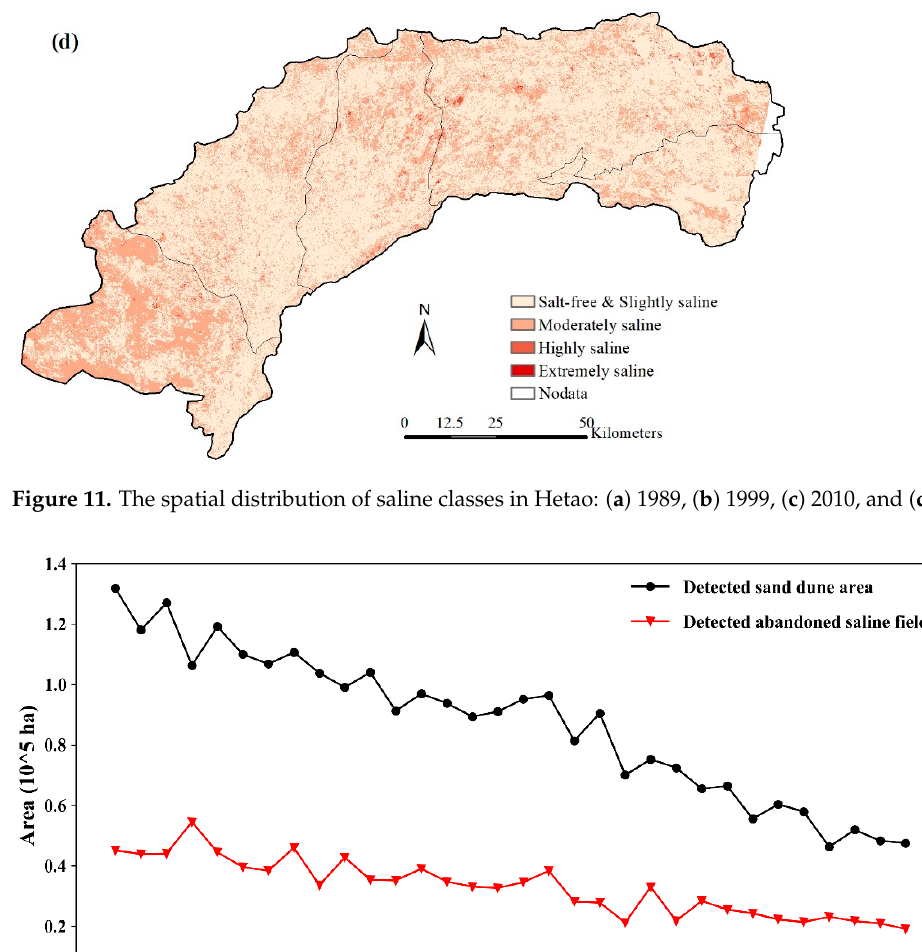
Figure 13. The spatial distribution of the detected abandoned salinized farmland from 1988 to 2018. 4.4. Validation of Land-Use Classification and Abandoned Farmland Detection A total of 150 verification points were used to evaluate the performance of the land-use classification and abandoned farmland detection. As seen in Table 2, all metrics reached at least 0.7 and above, within the acceptable range. The proposed method achieved outstanding performance for wheat and water body classification, with all metrics higher than 0.93. This is because the temporal VI patterns of wheat and water bodies are significantly different from those of other land uses, making them easier to classify. The confusion matrix in Figure 14 shows that pixels in residential areas were